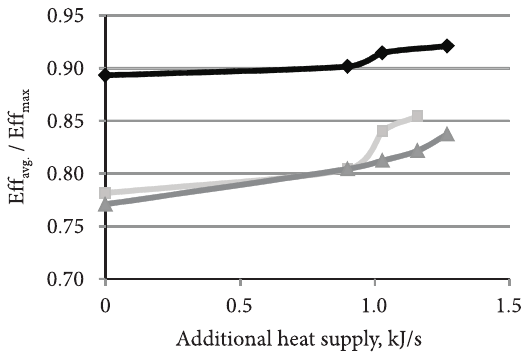
Fig. 7. η /η at different velocity of propane-butane supply avg. max and at different moisture content in wood pellets